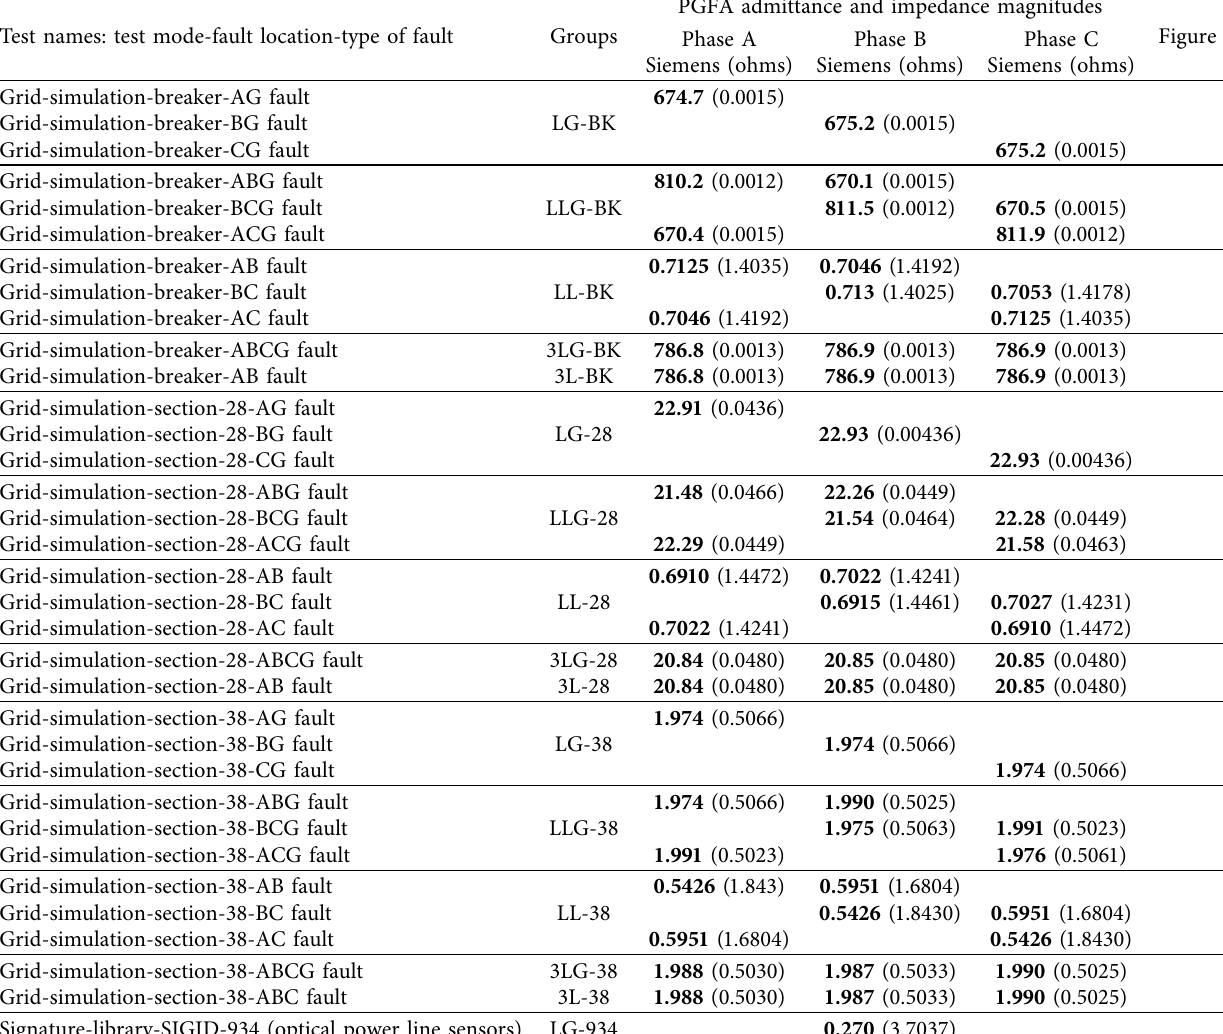
Table 5: Measured PGFA admittance and impedance magnitudes of the fault states. Test names: test mode-fault location-type of